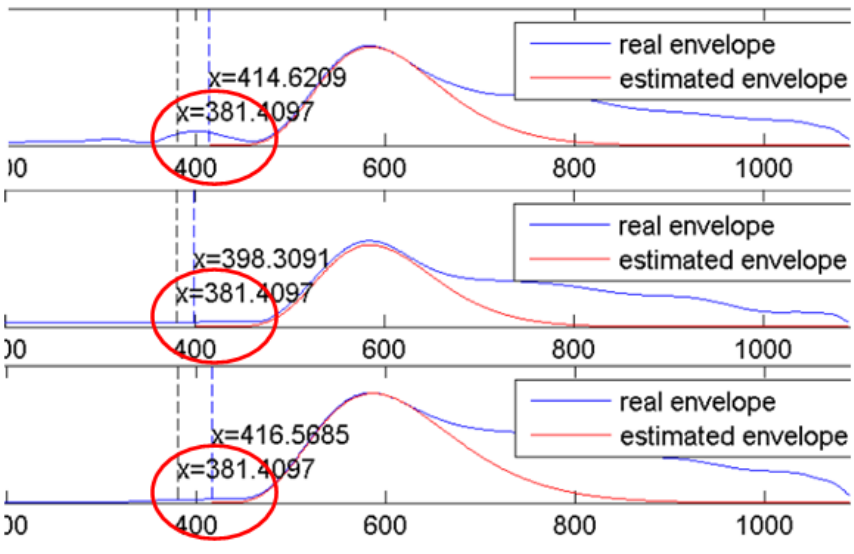
Figure 2. Distorted shapes of envelope